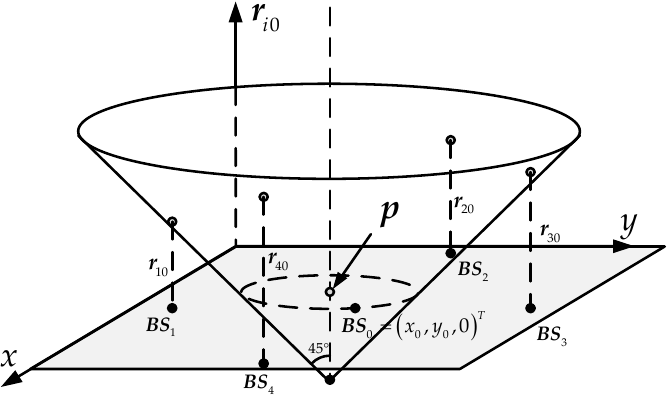
Figure 2. Localization diagram of FoPC algorithm using the space-range frame, as in [18].